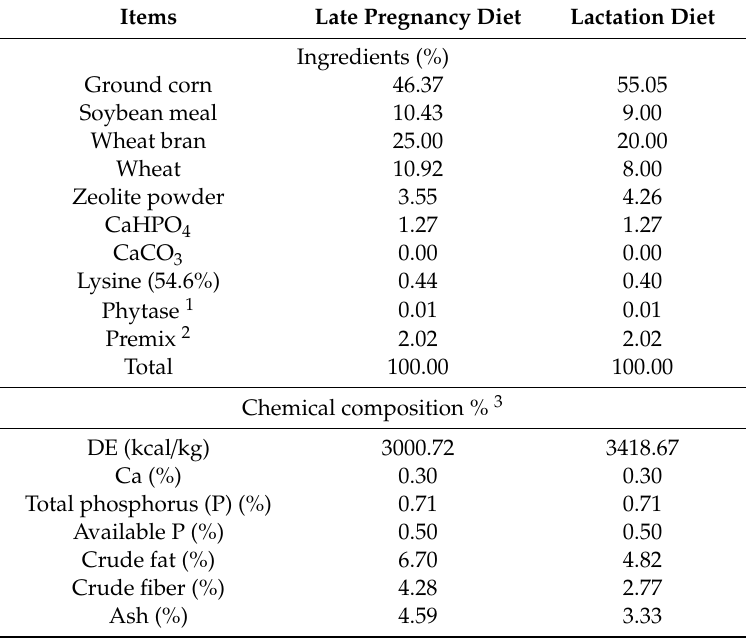
Table 1. Composition and nutrient levels of diets (air-dry basis)